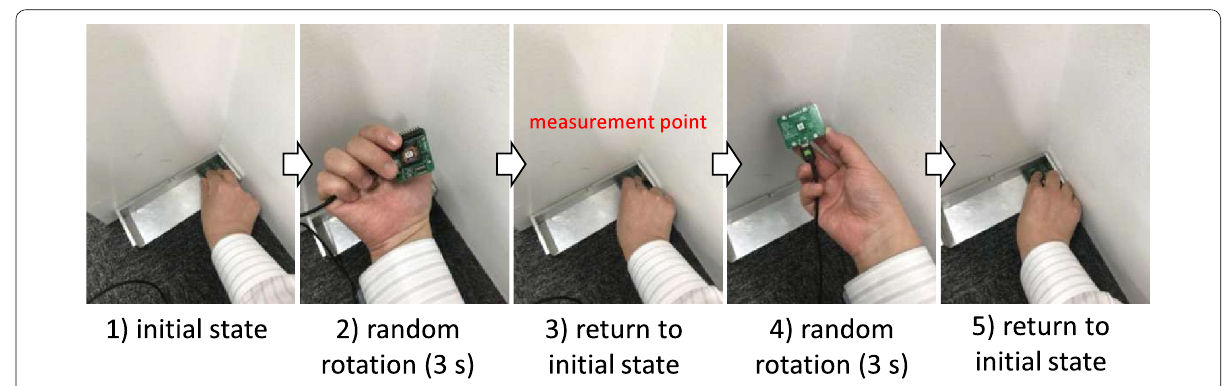
Fig. 9 IMU data collection procedure of attitude estimation experiment